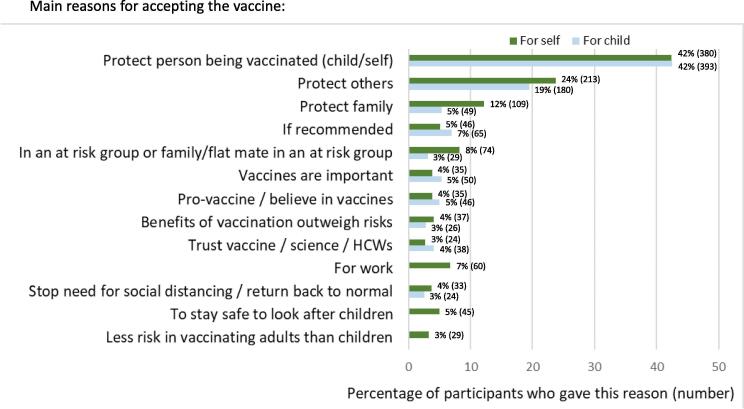
Main reasons for accepting the vaccine.